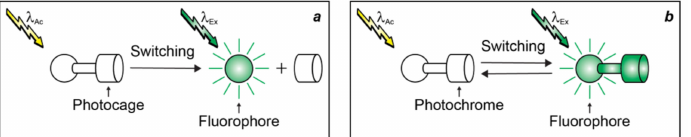
Figure 3. Structural designs for irreversible ( a ) and reversible ( b ) fluorescence photoactivation with fluorophore–photocage and fluorophore–photochrome constructs